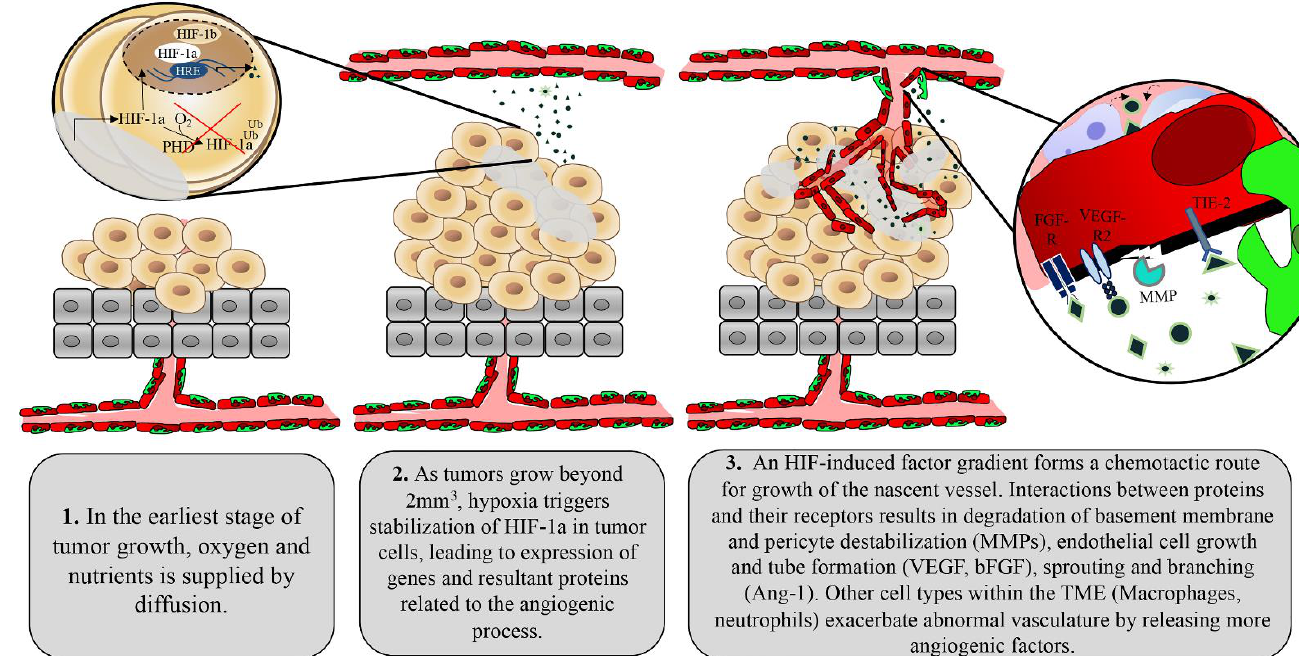
Figure 1. Hypoxia induced by the growing tumor mass triggers an “angiogenic switch” within the tumor microenvironment, resulting in a crude version of angiogenesis.